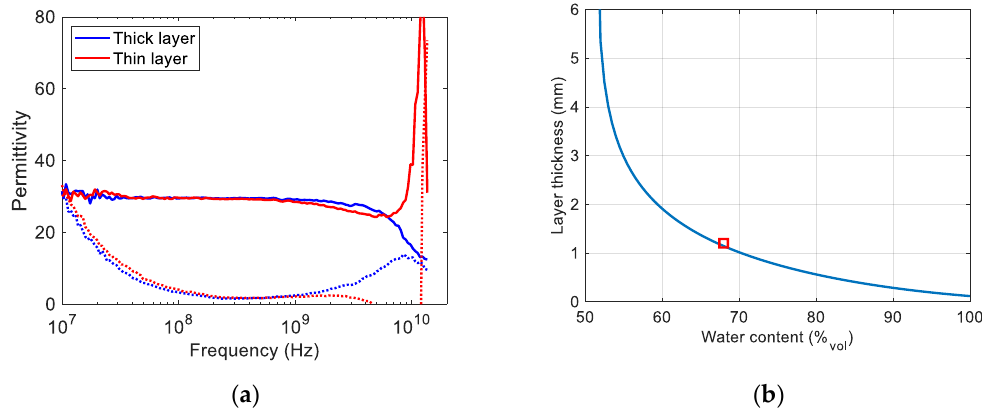
Figure 8. ( a ) Measured permittivity of two hydrate layers ( b ) Thickness and water content combinations that corresponds to the low frequency permittivity part of the spectrum. The best fit from the COMSOL Multiphysics simulations is shown as a red square.